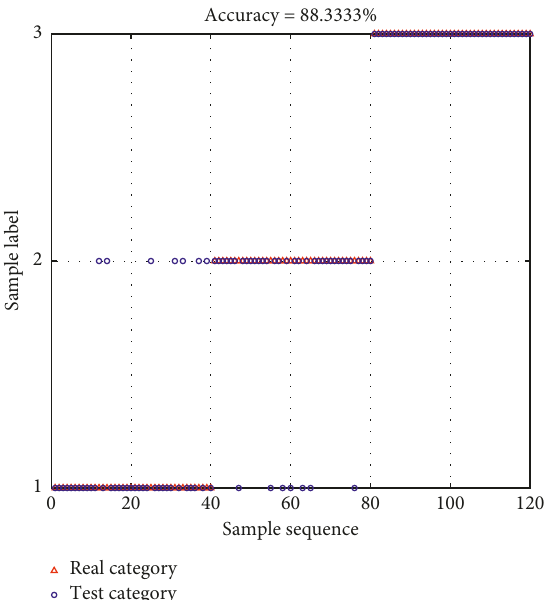
Figure 10: The spiral-bevel gear fault diagnostic results by using EEMD-based permutation entropy and